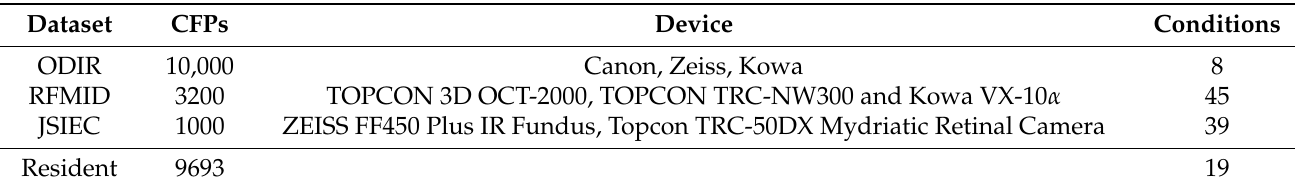
Table 1. Combining public